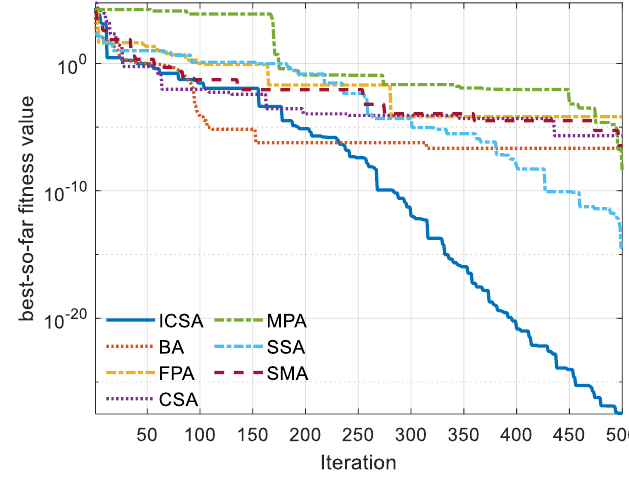
Figure 14. Convergence curve for F14.